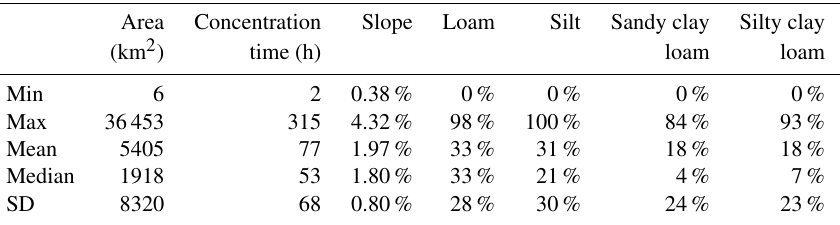
Table 2. The minimum, maximum, mean, median, and standard deviation (SD) of the watershed area, concentration time, average slope, and percentage of soil types including loam, silt, sandy clay loam, and silty clay loam among 125 USGS gauges in the State of